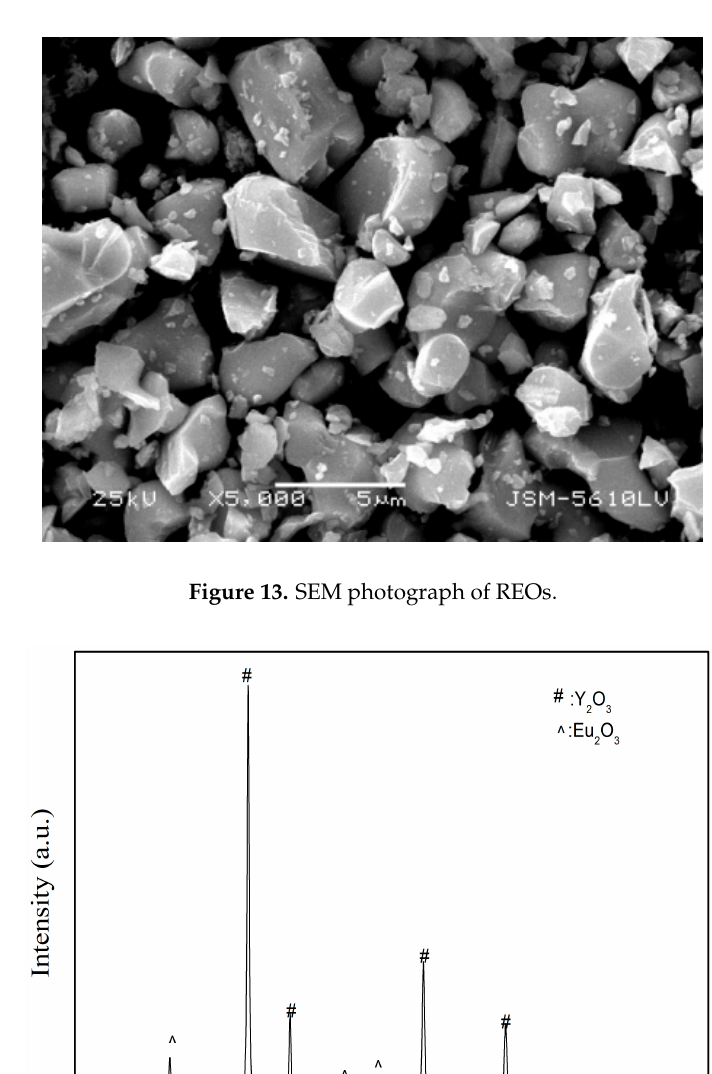
Figure 12. Effect of pH value on the precipitation ratios of RE elements.